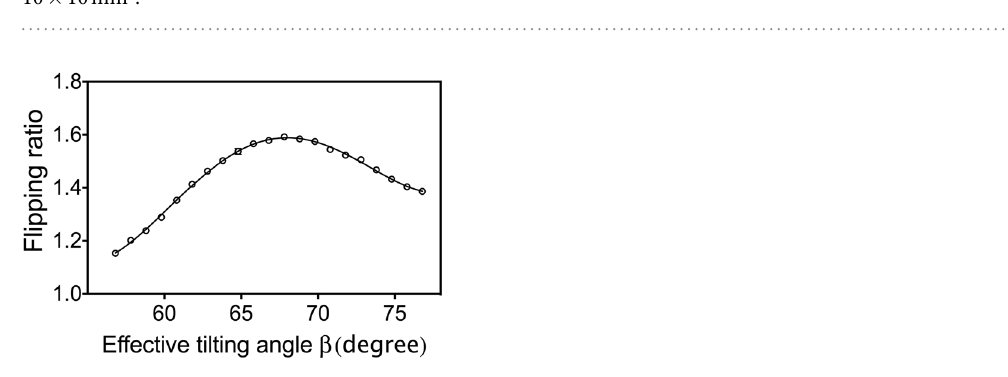
experiment), the green arrows in between the two arms are always in the plane. The red regions on the two ends of each arm denote rotatable guide fields. A view of these fields as seen by the neutron is shown in part (b) of Fig. 5. By simply rotating these guide fields, they can be set to any direction perpendicular to the neutron beam. For example, the first rotatable guide field can be set to be perpendicular to the field inside the device. Due to the Meissner effect produced by the superconducting film, the field regions inside and outside the prism will be well isolated yielding a non-adiabatic field transition so that the neutron spin will start to precess after entering the device. Since, when the experiment was conducted, no suitable zero-field environment was available for the sample region, two rotatable guide fields were used in between the two arms. By changing the configurations of the four rotatable guide fields, different operation modes can be achieved. For example, by setting the first and second rotatable guide fields to be perpendicular to the main field inside the first arm, while keeping the third and fourth guide field parallel to the main field, a single-arm Larmor diffraction setup could be achieved. Also, all the rotatable guide fields can be set to be perpendicular to the main field and with this configuration, only a maximum of 50% of the polarization can be achieved after the second arm, as shown later in Fig. 6(a) and (b). The setup involving a perpendicular field in between the two arms is called the ferromagnetic setup in NSE experi- ments, as first shown by Farago and Mezei 21 .